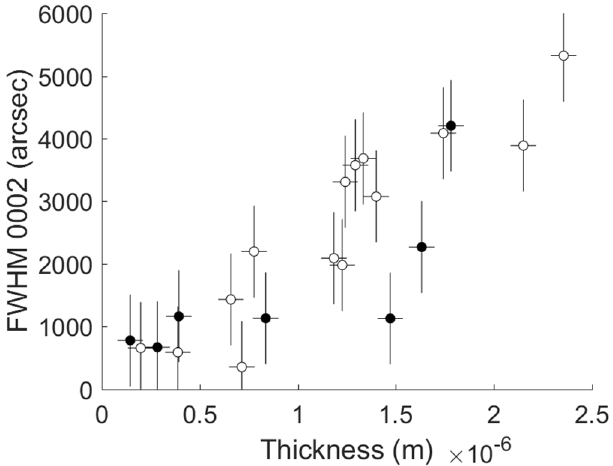
Figure 7. Crystal quality versus thickness of the AlN layer. Full dots indicate sample with cracks. Standard deviation is indicated.